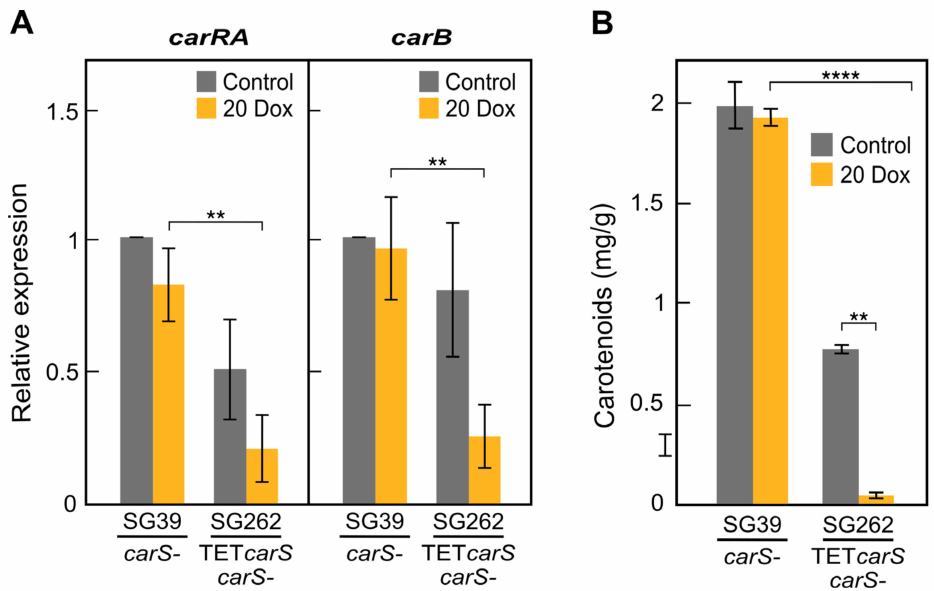
Figure 4. Repression of the carotenoid biosynthesis pathway by carS overexpression in the carS mutant: ( A ) Transcripts levels for the carB and carRA genes in the TET carS transformant (SG262) and the carS mutant (SG39). Cultures of SG39 and SG262 grown for 18 h were induced with 20 µ g/mL of Dox and then incubated for up to three days in darkness. The noninduced controls were grown for three days without Dox. Quantitative RT-PCR values represent average and standard deviations of two independent experiments. ( B ) Carotenoid content from the same strains grown on DG agar medium with 20 µ g/mL of Dox, and without Dox as control, for seven days in darkness. Mycelial samples were taken from three independent experiments. ** p < 0.01; **** p <